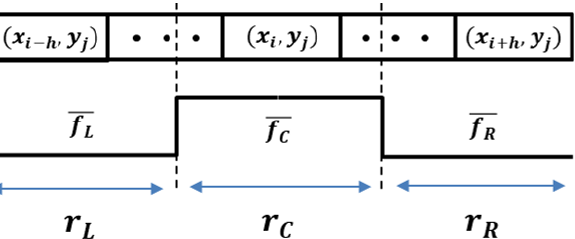
Figure 3. The proposed lane-marking hat filter. r L , r C , and r R are the size of each region. i , j , and h are indices for the width and the height of the image, and the filter size, respectively. They are satisfying: i − h ≥